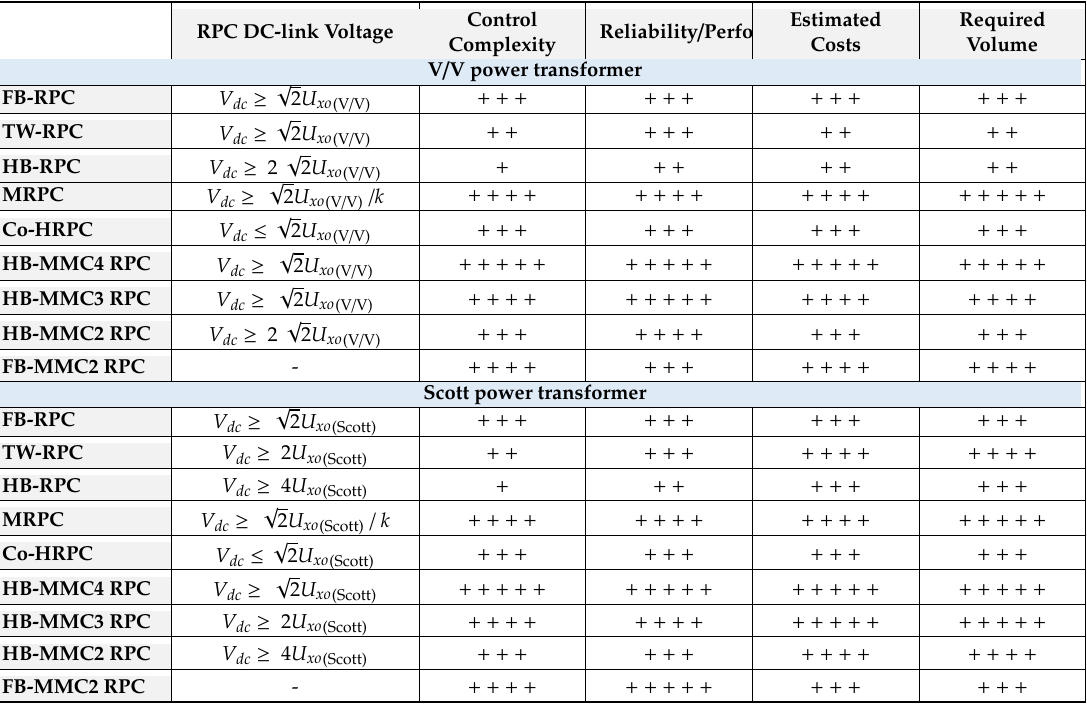
Table 17. Characteristics of the RPC topologies in V / V and Scott transformer (based on